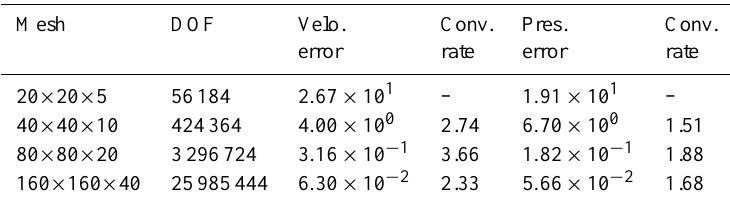
Table 1. L 2 errors in the velocity and pressure simulated by the parallel high-order accurate, finite element Stokes ice-sheet model at the initial state t =